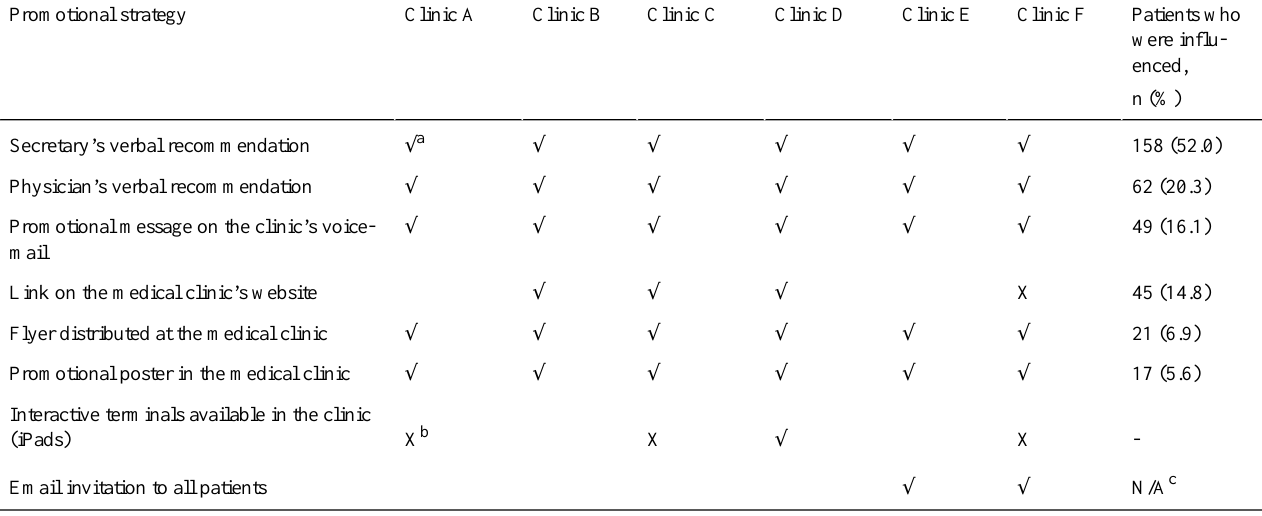
Table 5. Promotional strategies put in place and patients’receptiveness